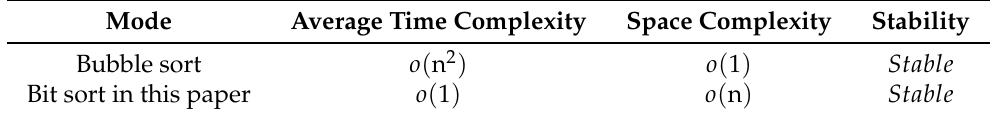
Table 2. Comparison of bubble sort and bit